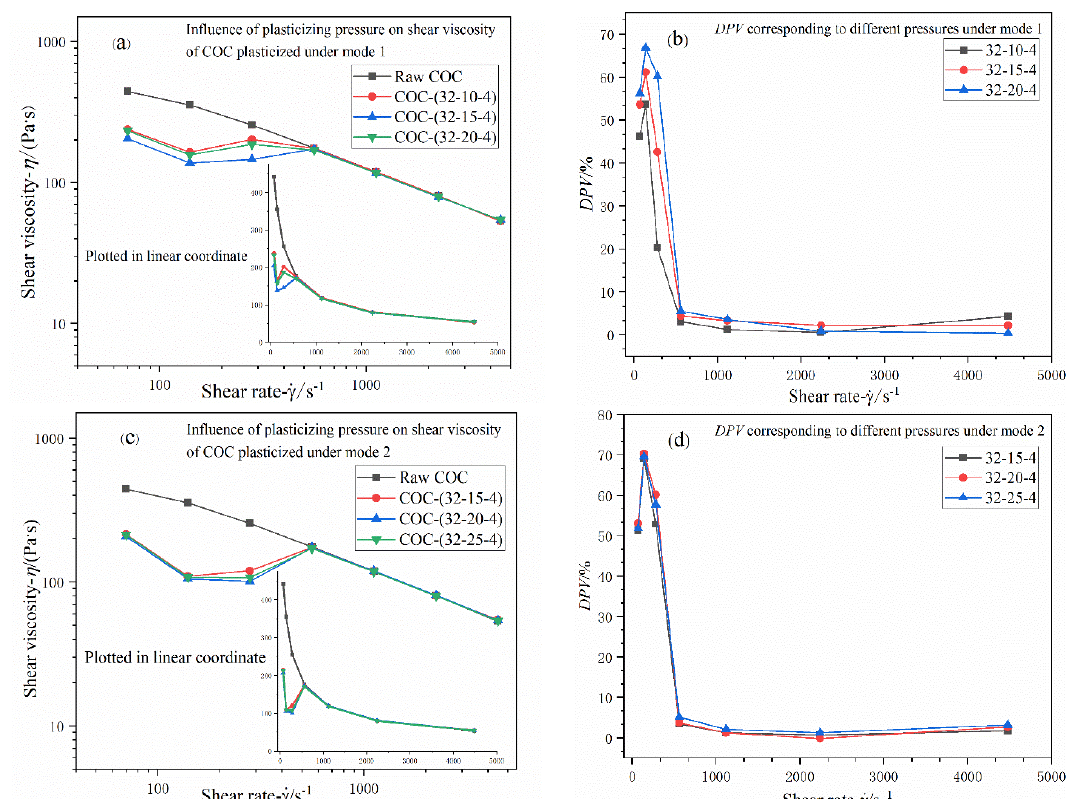
Figure 8. ( a , c ) Influence of adjusting plasticizing pressure on shear viscosity of COC plasticized in Mode 1 and Mode 2; ( b , d ) DPVs corresponding to di ff erent plasticizing pressures under two di ff erent modes. Nomenclature: ultrasonic amplitude ( µ m); plasticizing pressure (MPa); ultrasonic action time (s).